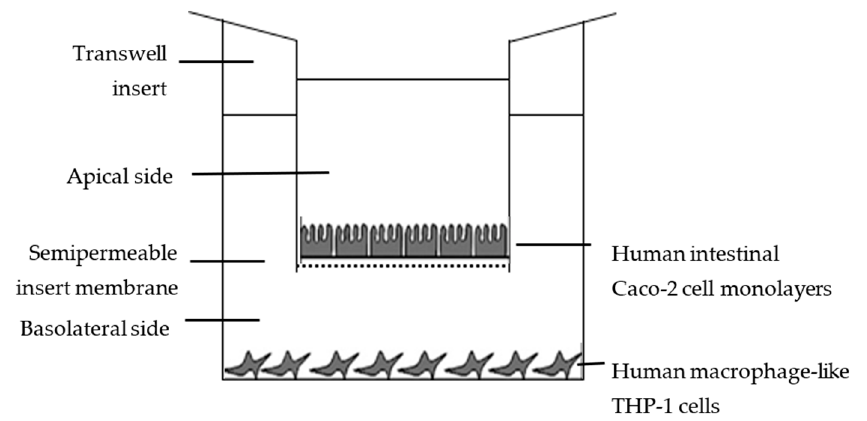
Figure 1. Schematic representation of the co-culture system of Caco-2 monolayer and LPS-stimulated THP-1-derived macrophages.